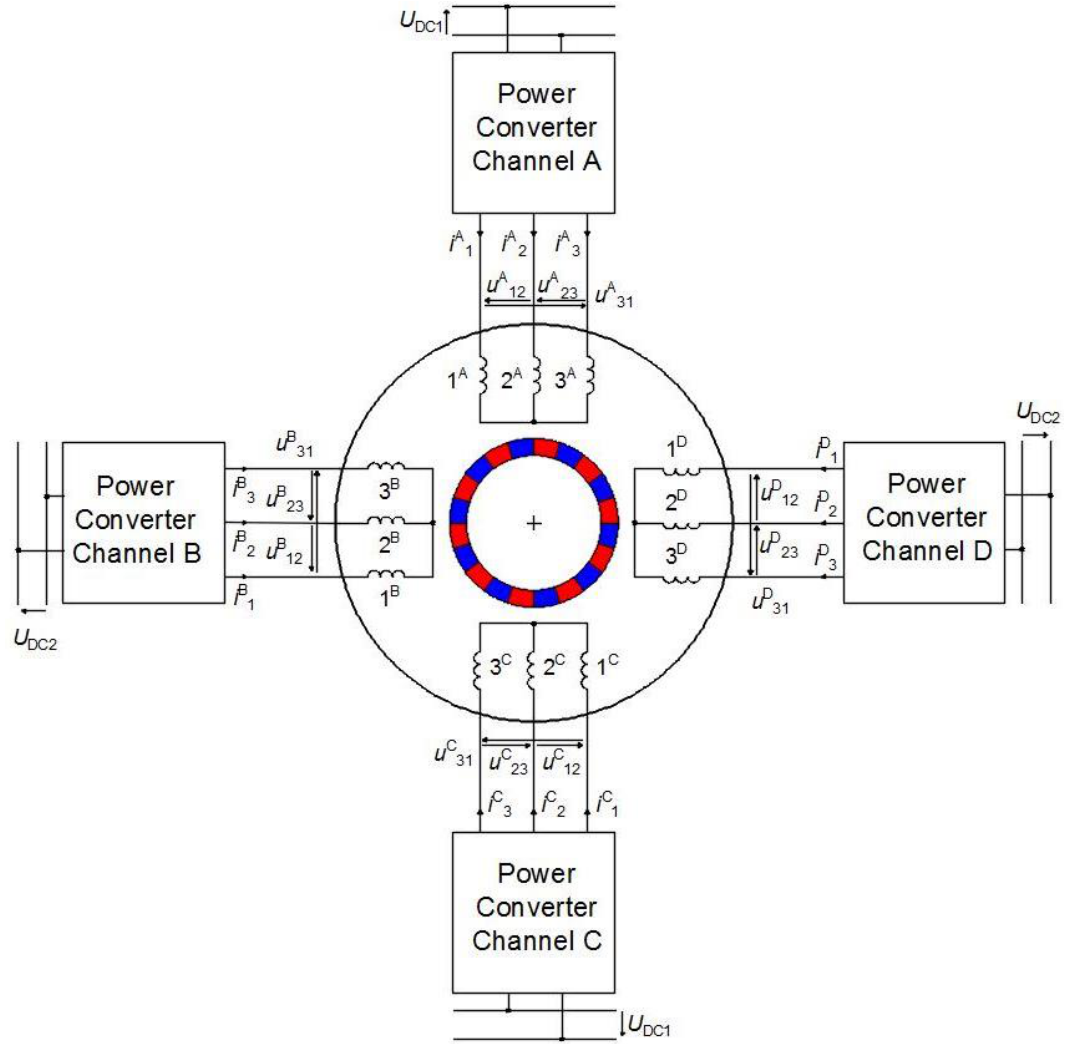
Figure 1. A scheme of a quad-channel brushless permanent magnet direct current (QCBLDC) supply system under quad-channel operation (QCO) mode with two supply sources.